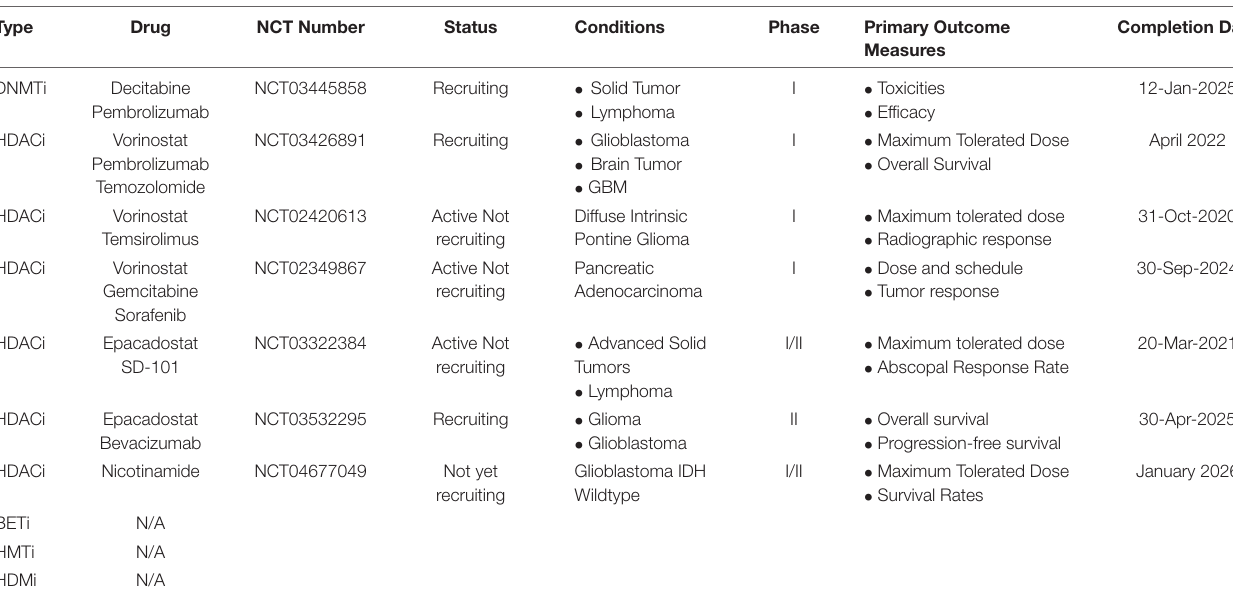
TABLE 3 | Ongoing clinical trials in epi-drug combined